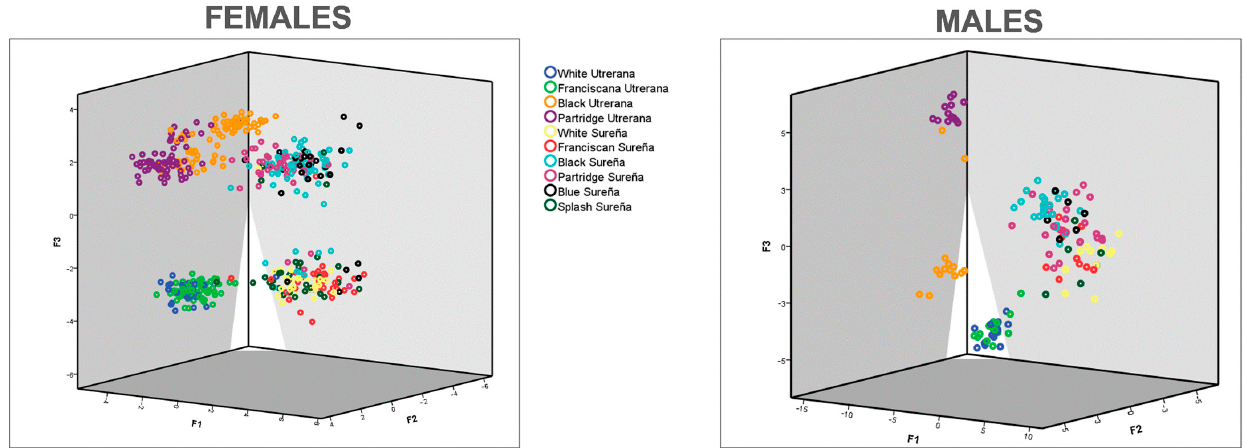
Figure 4. Territorial map depicting the observations considered in the canonical discriminant analysis sorted across genotypes.